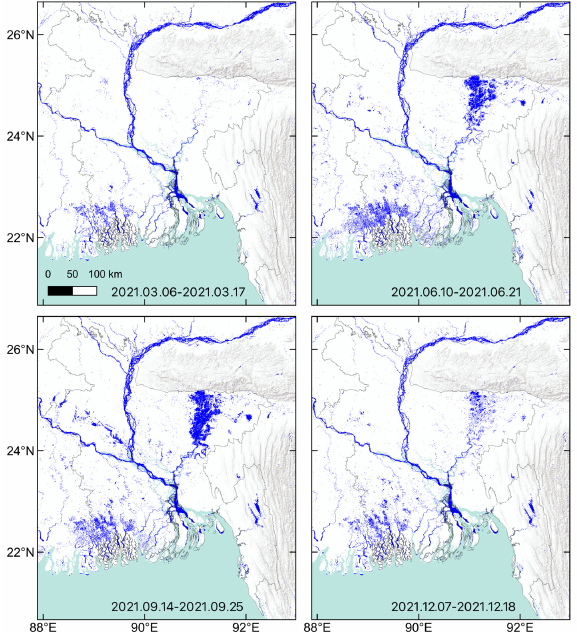
Figure 5. Water delineated in 12-day Sentinel-1 mosaics showing the evolution of flood in Bangladesh in